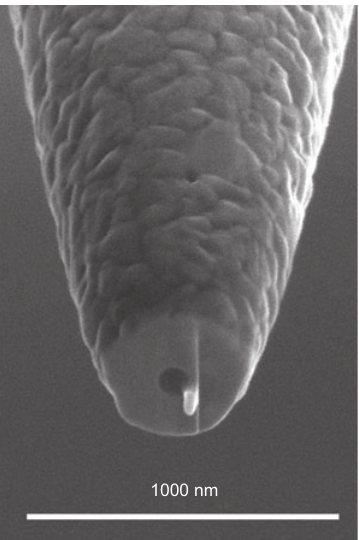
Figure 8 λ /4 nanorod antenna on an aperture probe tip fabricated by focused ion beam milling. Reprinted with permission from [82] .